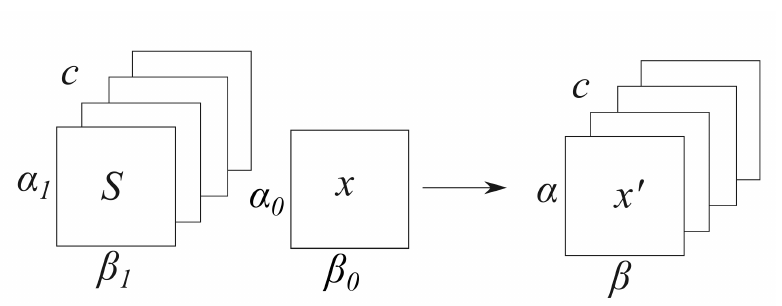
Figure A1. Parallel imaging shown as the index tensor operators. x α 0 β 0 is the spatial distribution of the transverse magnetization for the object. S α 1 β 1 c is a 3rd tensor for coil sensitivity profiles. α , α i , i = 0,1 indicates the first spatial dimension. β , β i , i = 0,1 indicates the second spatial dimension. c is the dimension for